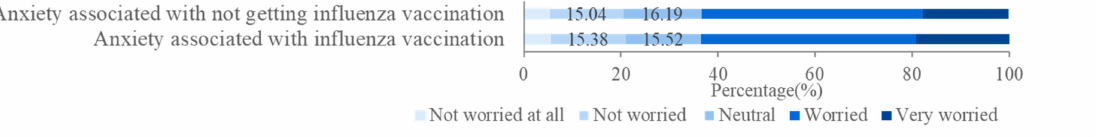
Figure 4. Access to vaccination service, influence of information sources, and caregivers’ emotion associated with influenza vaccination: ( A ) Access to vaccination service and cue to action; ( B ) The influence of different information sources on caregivers; ( C ) Caregivers’ emotion associated with influenza